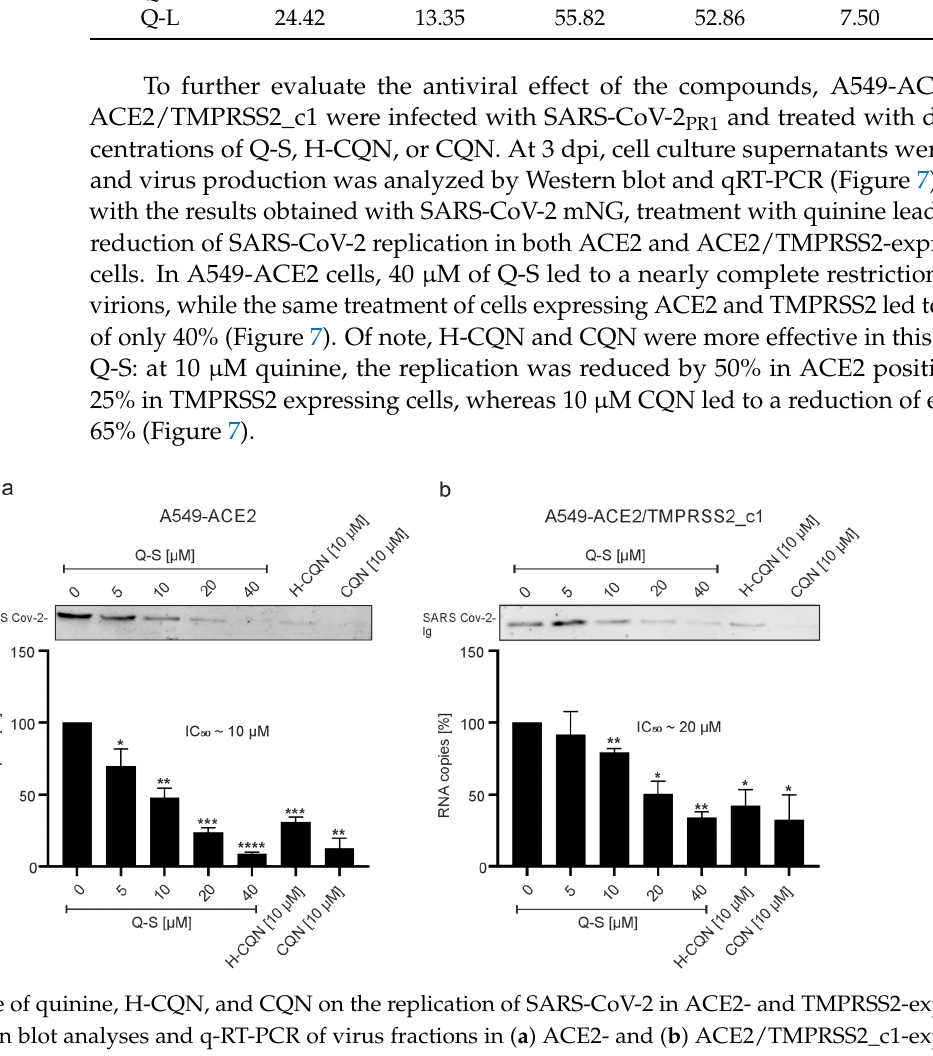
Table 2. IC 50 (µM) values of Q-L and Q-S in A549-cells stably expressing ACE2 and TMPRSS2. The IC 50 [µM] was calcu- lated with GraphPad Prism (log(inhibitor) vs. response—variable slope (four parameters)). MOI for hi is 1.1 and lo is 0.2. Compound IC 50 [µM]